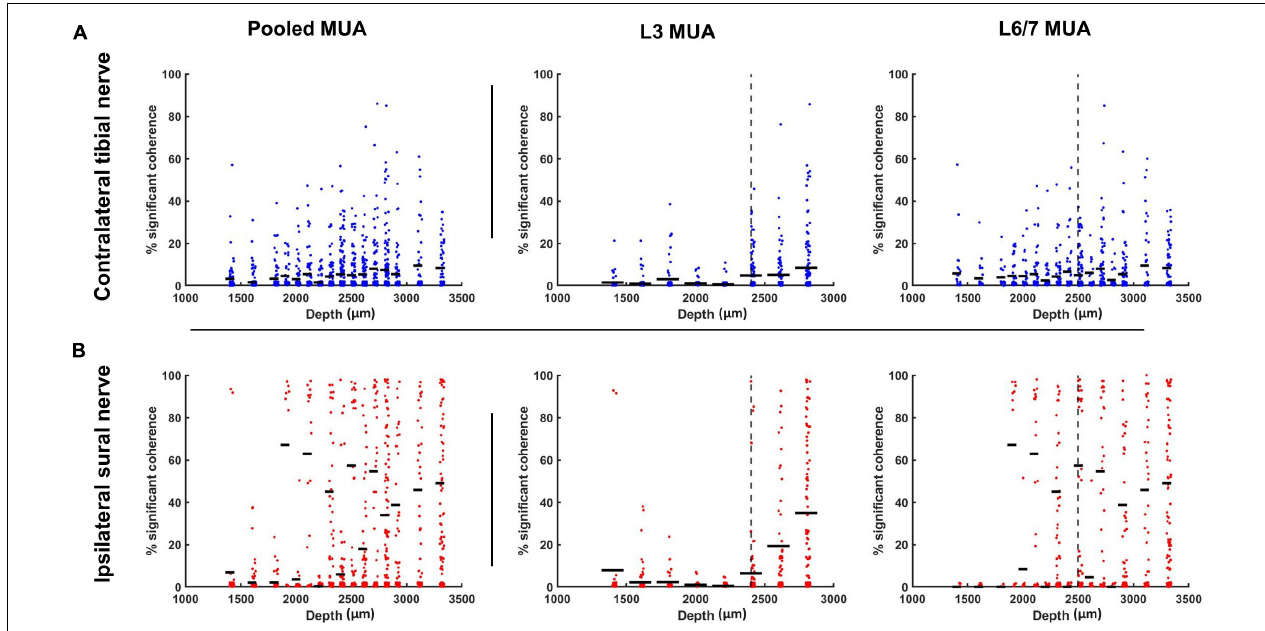
FIGURE 8 | Percentage of motor pool significantly cohered to discharge of individual interneurons (represented as single points) stratified as a function of interneuron depth for contralateral tibial [blue; (A) ] and ipsilateral sural [red; (B) ] nerve stimulation collapsed across frequencies. Horizontal dashes represent the mean percentage of motor unit cohered to individual interneurons within each depth bin. The vertical dashed line represents the median depth of the population of interneurons recorded at each spinal recording site. These median values were used to classify interneurons as superficial ( ≤ median) or deep ( > median) when examining the effect of interneuron depth on interneuron-motoneuron